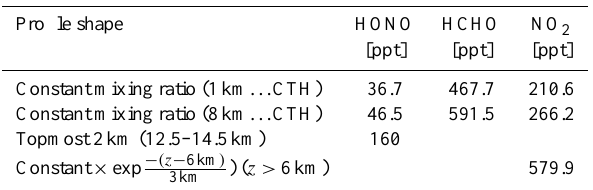
Table 7. Overview of different error sources and the influence on the retrieved mixing ratios. To estimate the error of the profile a constant mixing ratio above 8km was used here. Error [ppt] HONO HCHO NO 2 Standard values 36.7 DOAS retrieval ± 7 ± 80 ±